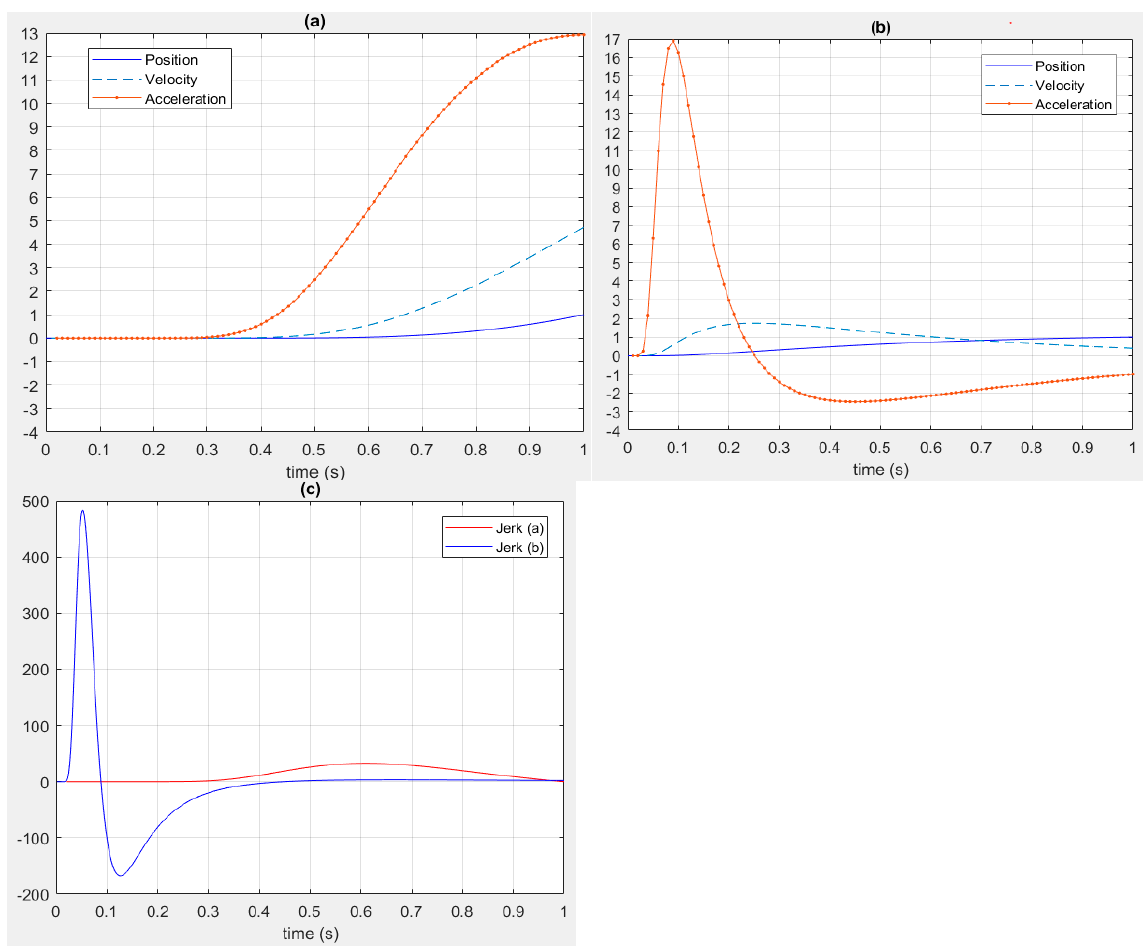
Figure 6. ( a ) and ( b ) show position, velocity, and acceleration and ( c ) shows the Jerk of the trajectory in a second, starting in the position 0 and finalizing in 1 using different values of 𝑎 to change the velocity and acceleration (the parameter 𝑎 of ( a ) is greater than the parameter 𝑎 of ( b )).